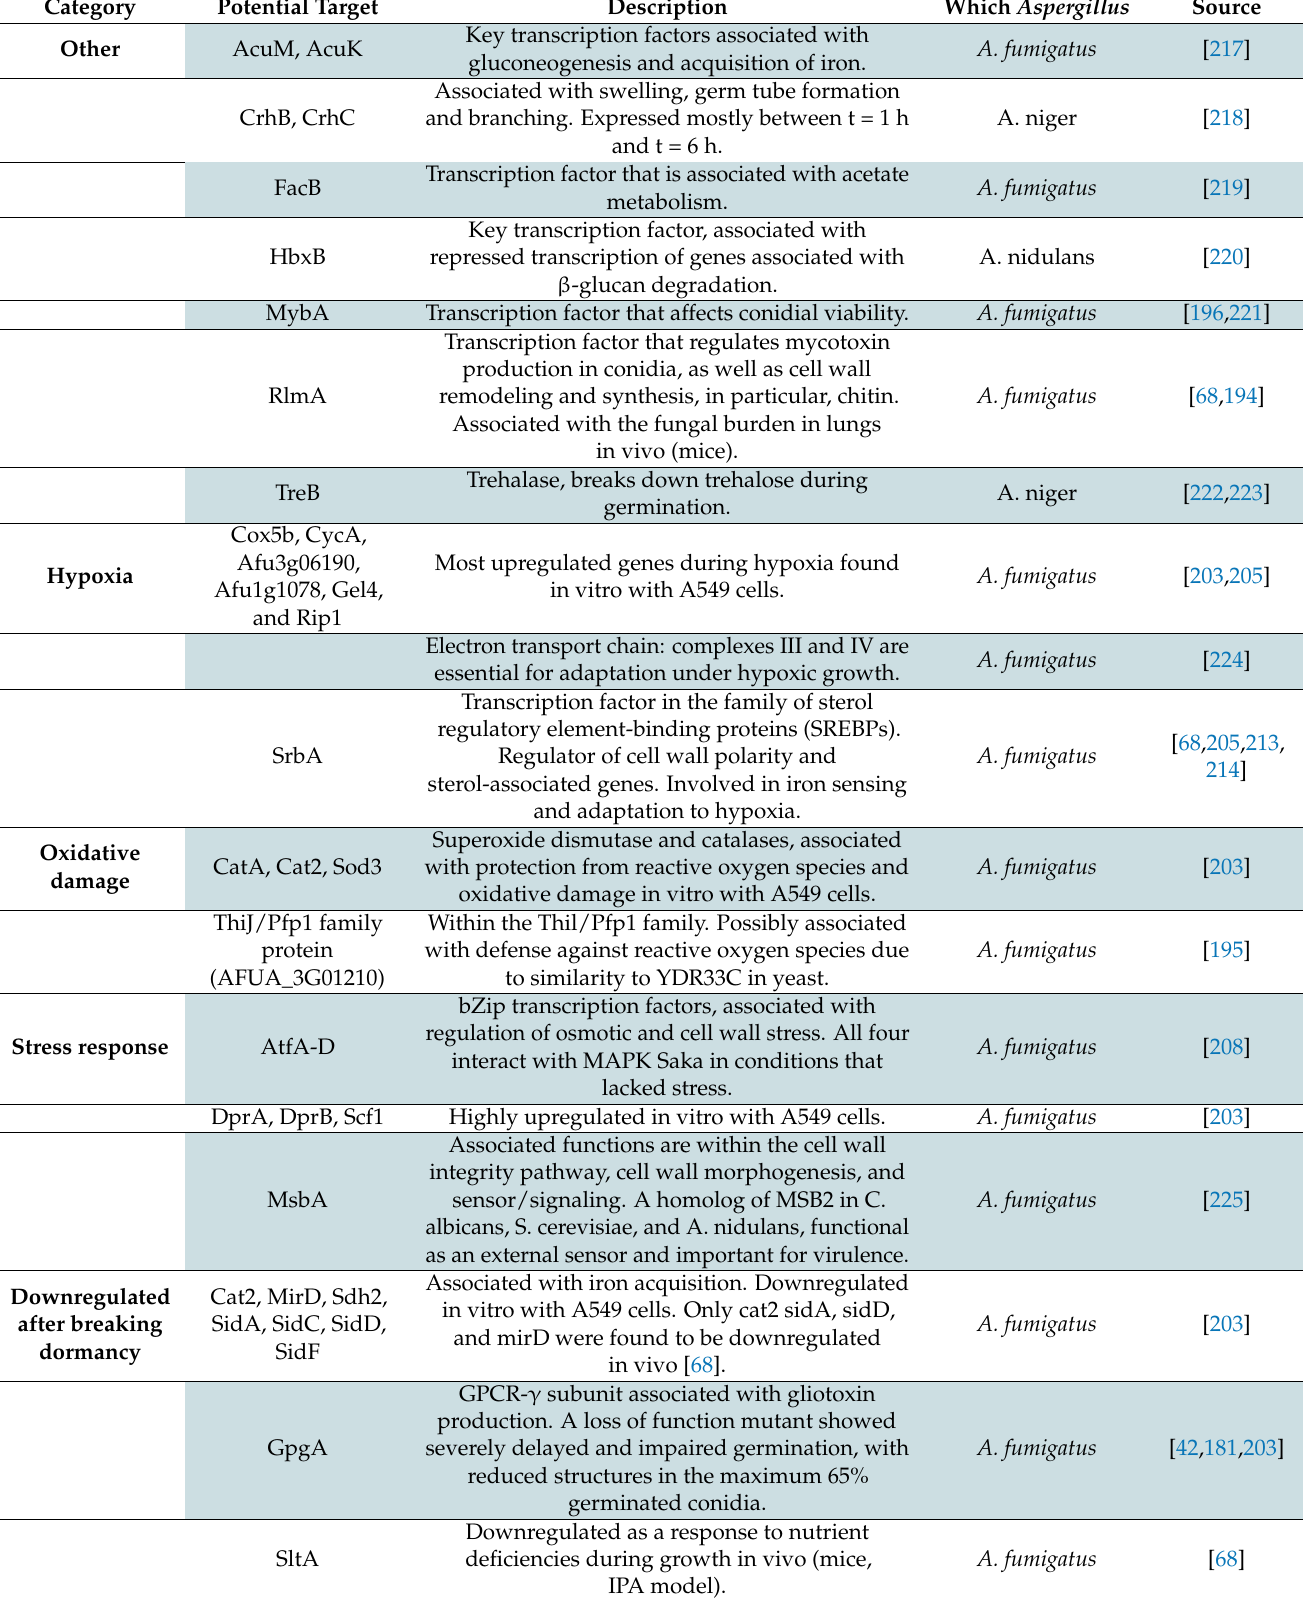
Table 3. Other potential targets to disrupt the germination of Aspergillus